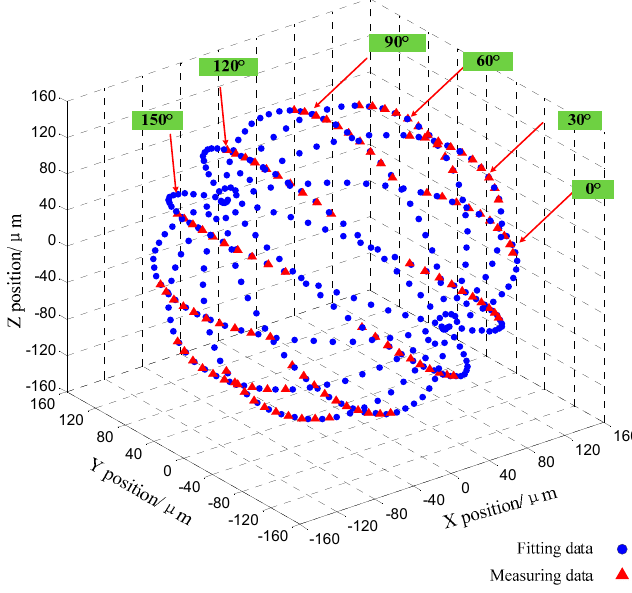
Figure 14. The measured and fitted data of the six cross-section profiles.